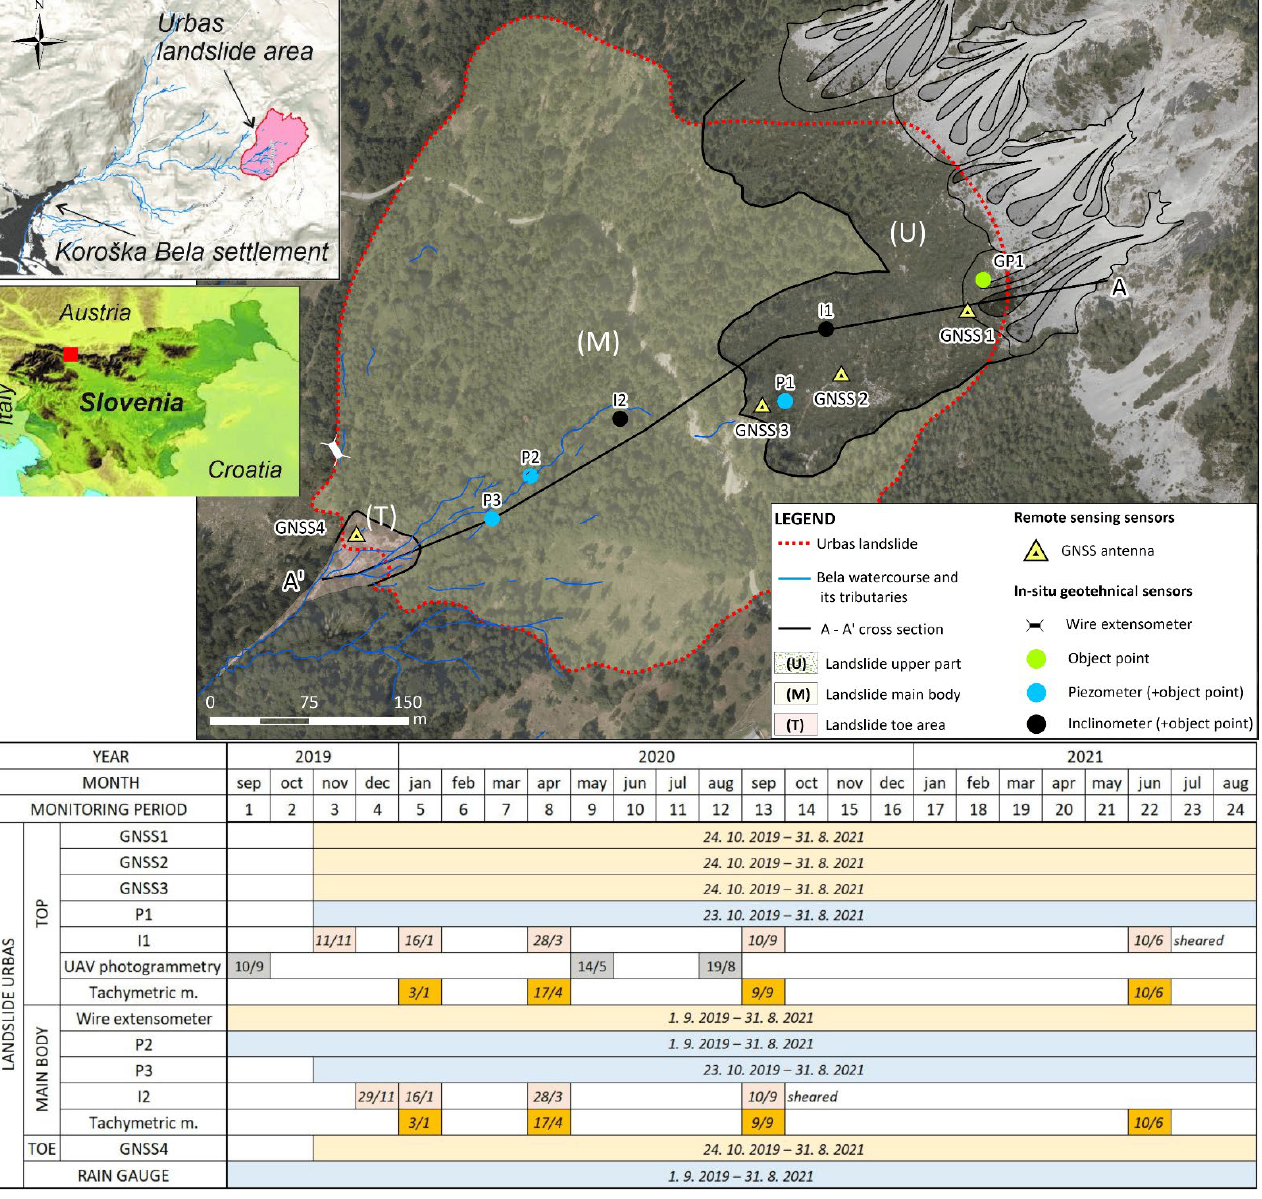
Figure 1. Location of the study area and the spatial and temporal distribution of applied